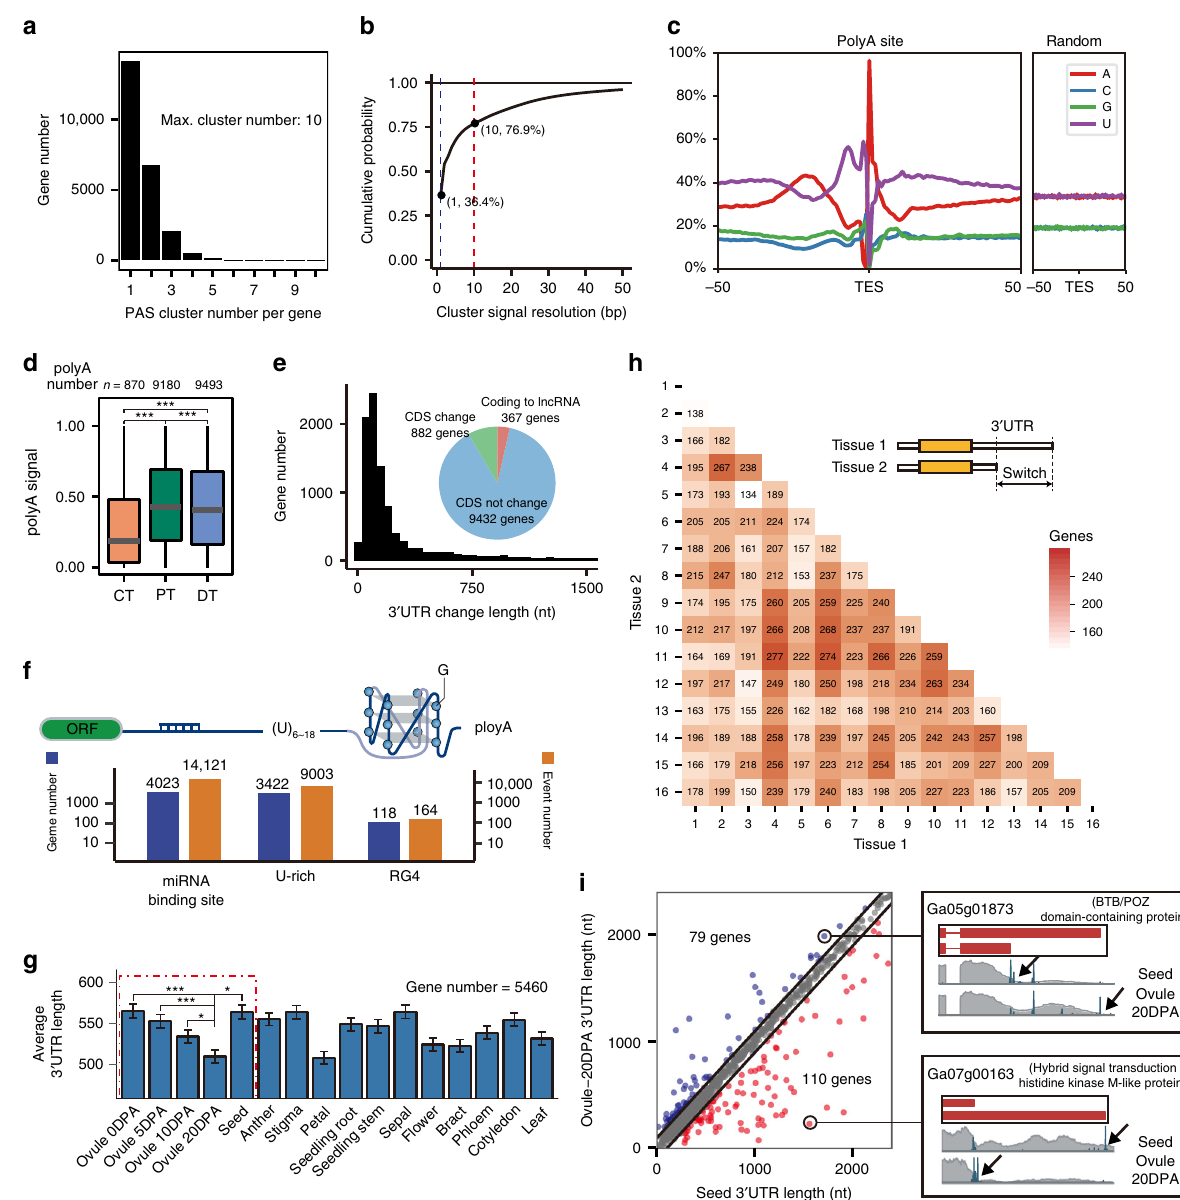
Fig. 3 Multiple transcription termination and alternative 3 ′ UTR usage in G. arboreum . a Statistics of transcription end site (TES) per gene. b Cumulative curve of base resolution of the TES cluster signal from PolyA-seq. c The nucleotide composition around the TES. d Statistics of TES usage in genes with multiple TESs including distal- (DT), proximal- (PT) and coding-TESs (CT). e Statistics of effect on RNA (pie chart) and the distribution of change of CDS length due to the use of an alternative TES. f Potential functional RNA elements in the alternative 3 ′ UTRs including RBP binding, U-rich, and RG4 motifs. g Average 3 ′ UTR length across tissues (error bar represents s.e.m.). h Number of genes with alternative TES usage between pairwise tissues. i Genes with changes in APA between ovule (20 DPA) and seed (left), and two representative gene examples (right). The signi fi cance levels are indicated by asterisks (* p -value < 0.05; ** p -value < 0.01; *** p -value < 0.001), and the median values in box plots are shown. The source data underlying Fig. 3b – h are provided